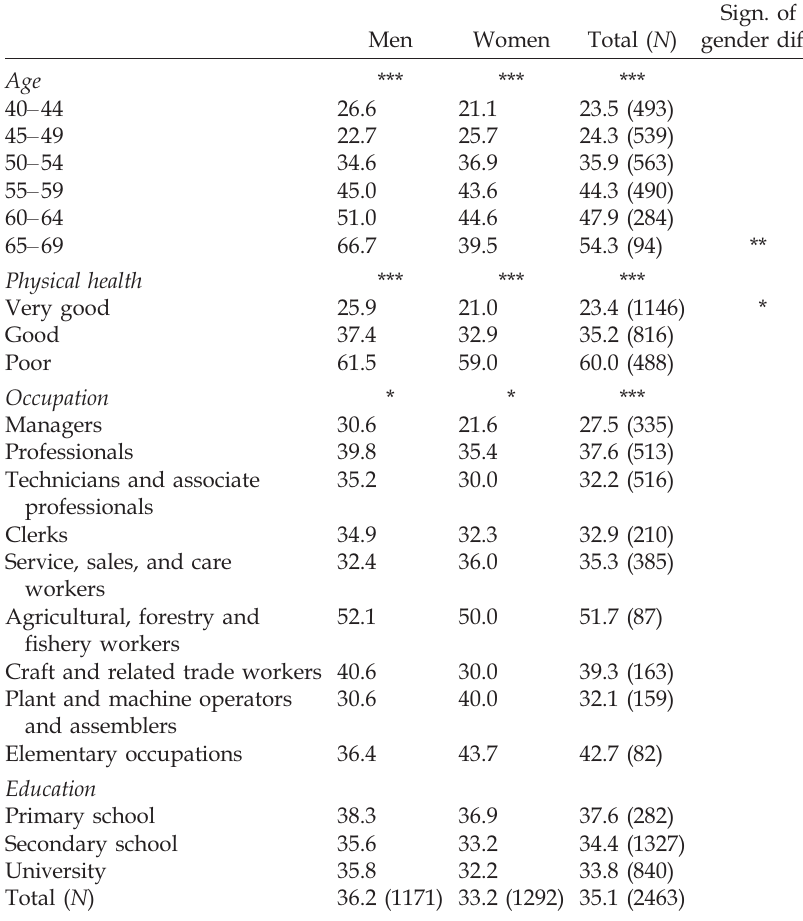
Table 4. Proportion experiencing declining work ability o v er the last ten years among employed persons aged 40 (cid:1) 69 years, by age, gender, physical health (SF-12), occupation and education. NorLAG.